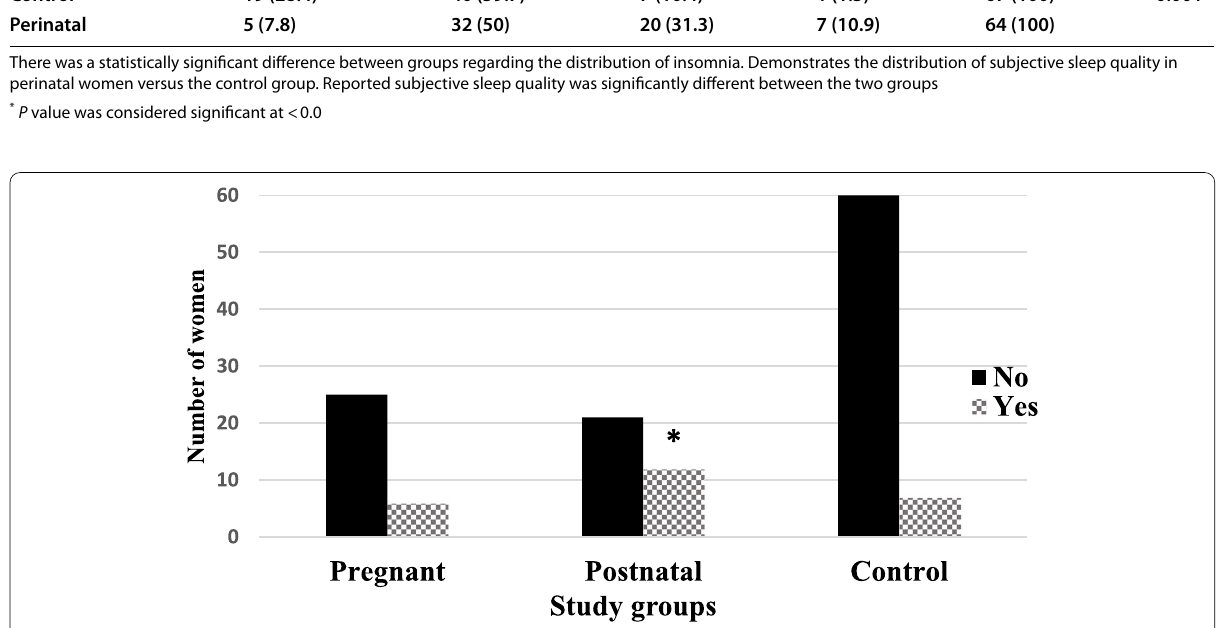
Fig. 1 Insomnia among perinatal women subgroups. Kruskal‑Wallis test is used. Pregnant is not different from control P >0.05, and *postnatal group is statistically different from control P =